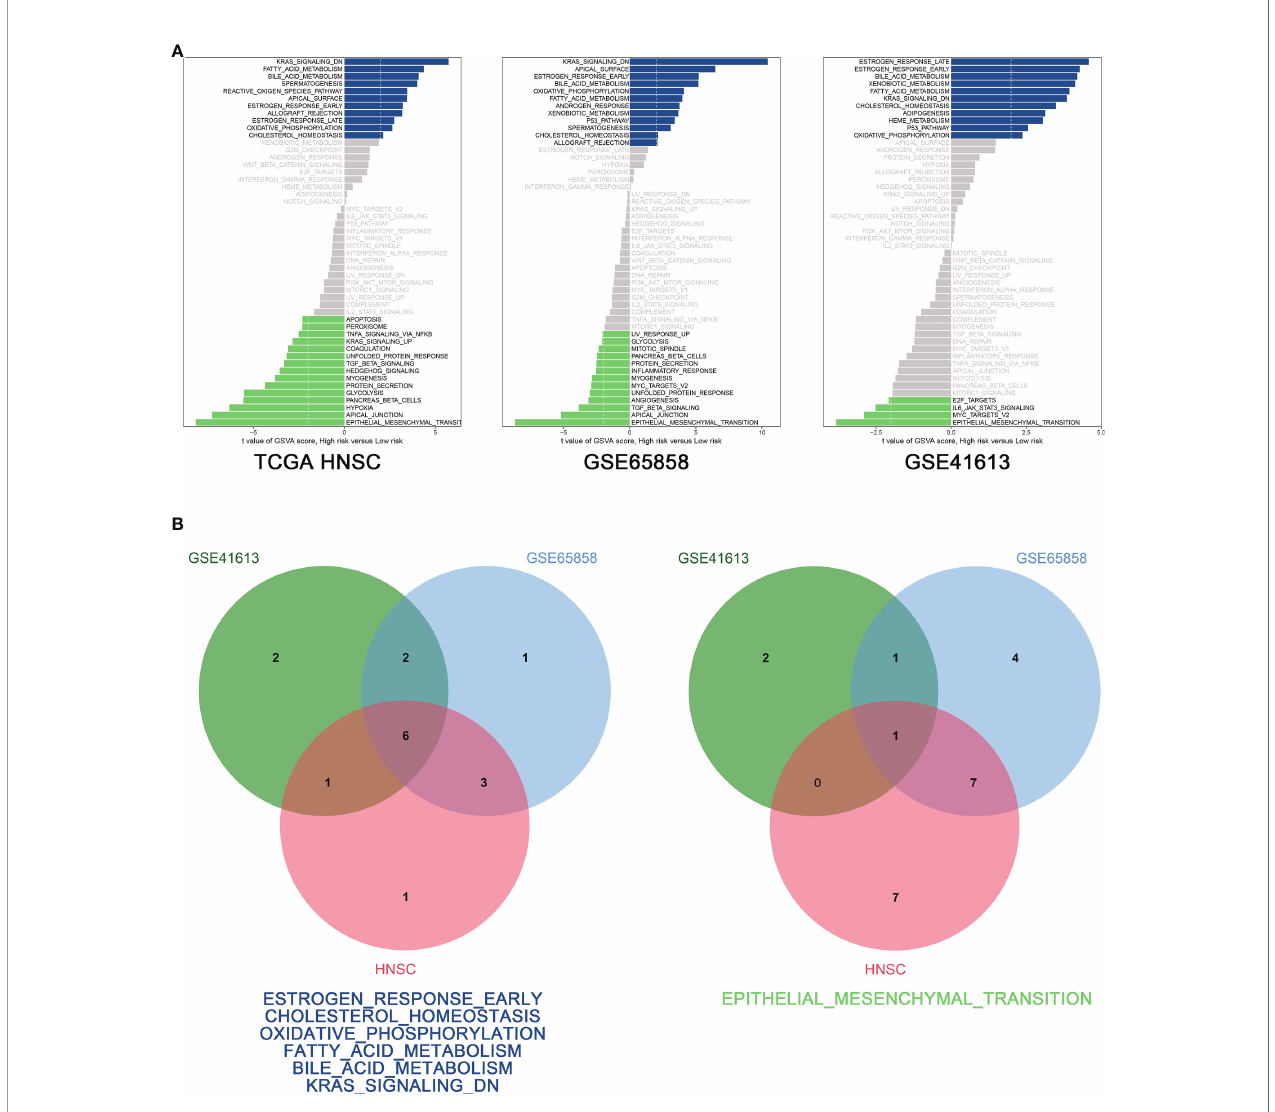
FIGURE 8 | GSVA analysis. (A) GSVA of the TCGA-HNSC (a), GSE65858 (b), GSE41613 (c) data sets. (B) Venn diagram of the activated (a) and suppressed (b) gene sets in the indicated data